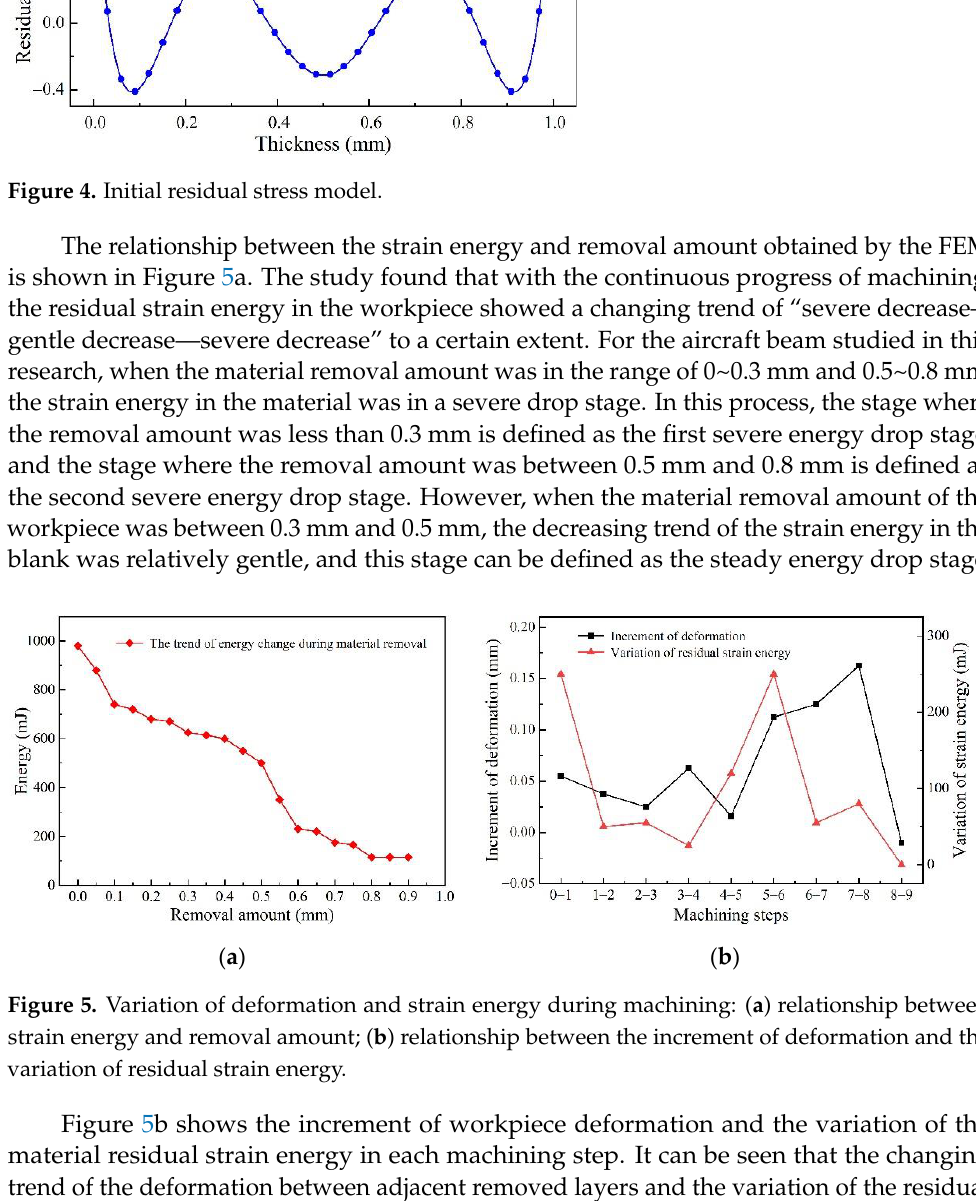
Figure 3. Schematic of material layer-by-layer milling.